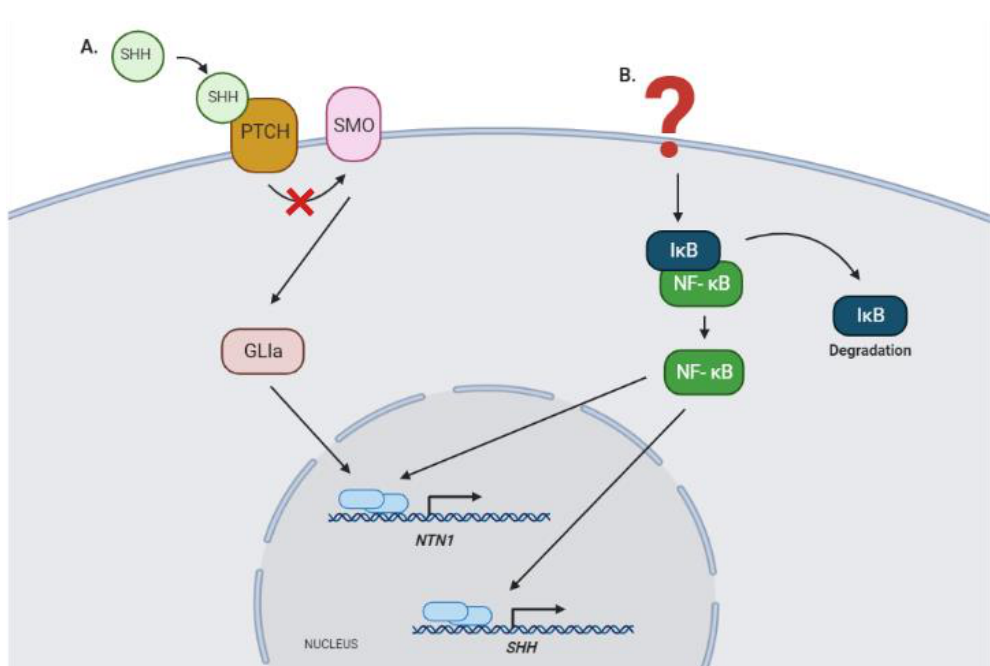
Figure 2. Signaling pathways that could regulate the expression of NTN1 in GBM. ( A ) NTN1 expression could be regulated by the canonical SHH signaling pathway, as described recently on medullobastoma, specifically through the transcriptional function of activator isoforms of the GLI zinc finger proteins (Falcon et al., unpublished observations) [72]. ( B ) Alternatively, the NF- κ B pathway could modulate NTN1 expression, directly through binding to the promoter region of this gene, or indirectly through the regulation of SHH expression [74,75]. GLIa, GLI 1, and GLI2 activator forms; SHH, Sonic Hedgehog protein; PTCH, Patched protein receptor; SMO, Smoothened protein; I κ B, inhibitor nuclear factor kappa B; NF- κ B, nuclear factor kappa B; NTN1, Netrin-1 gene.